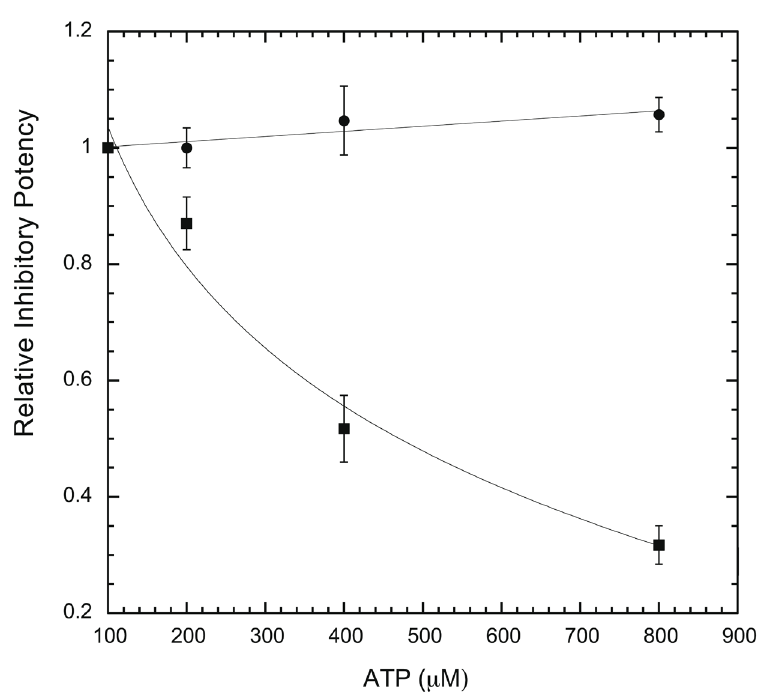
Figure 7. ATP competition assay. For each inhibitor (epigallocatechin gallate (EGCG) and harmine), assays were conducted with a single concentration of inhibitor in four different ATP concentrations (100, 200, 400, 800 μM) and quantified as described in Methods. The inhibitory potency at three other ATP concentrations was calculated as relative to that at 100 μM ATP and used to plot against ATP concentrations. Inhibitor concentrations used in the assays were 0.4 μM for EGCG ( ● ) and 0.2 μM for harmine ( ▪ ) (n = 6 for each data